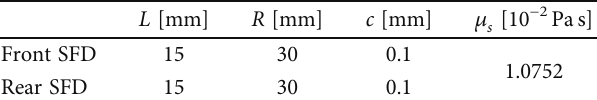
Table 1: SFD parameters.